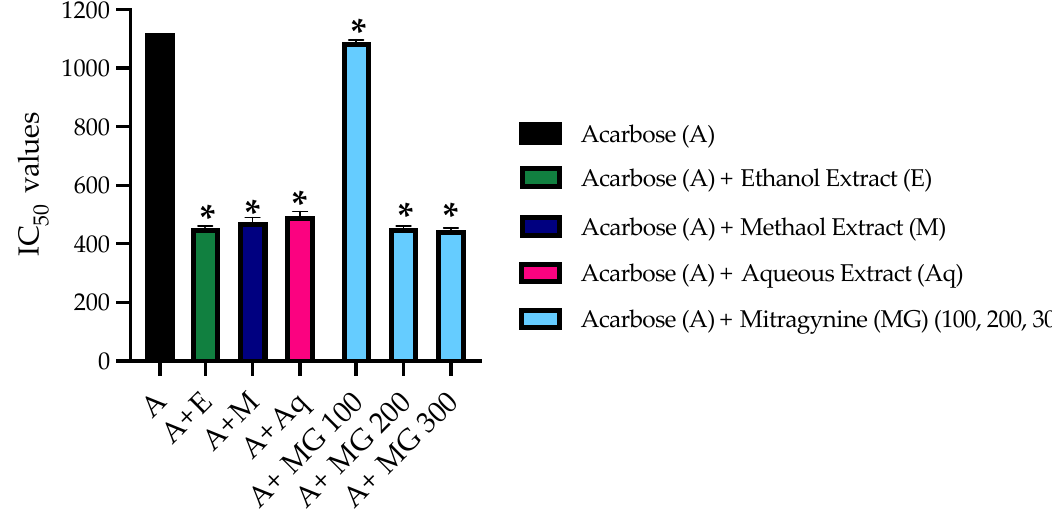
Figure 5. The IC 50 values α -glucosidase of combinatorial kratom extracts and mitragynine with acarbose. The results are expressed as the means ± SDs, n = 3. * p < 0.05 compared to acarbose alone.